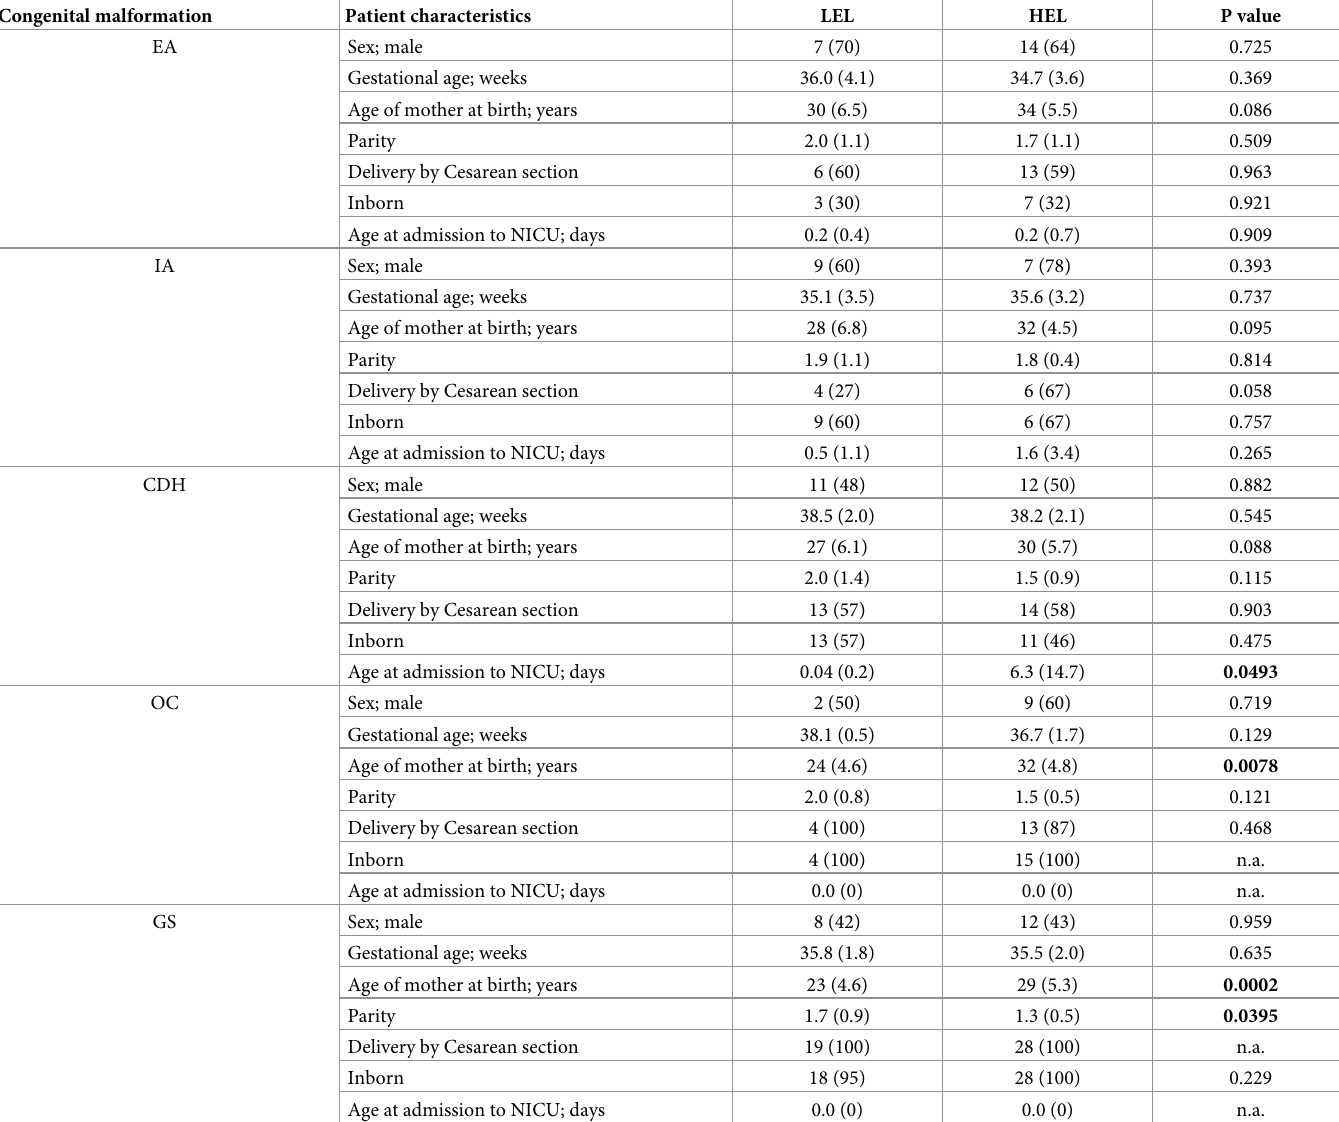
Table 3. Characteristics of n = 169 included patients with congenital